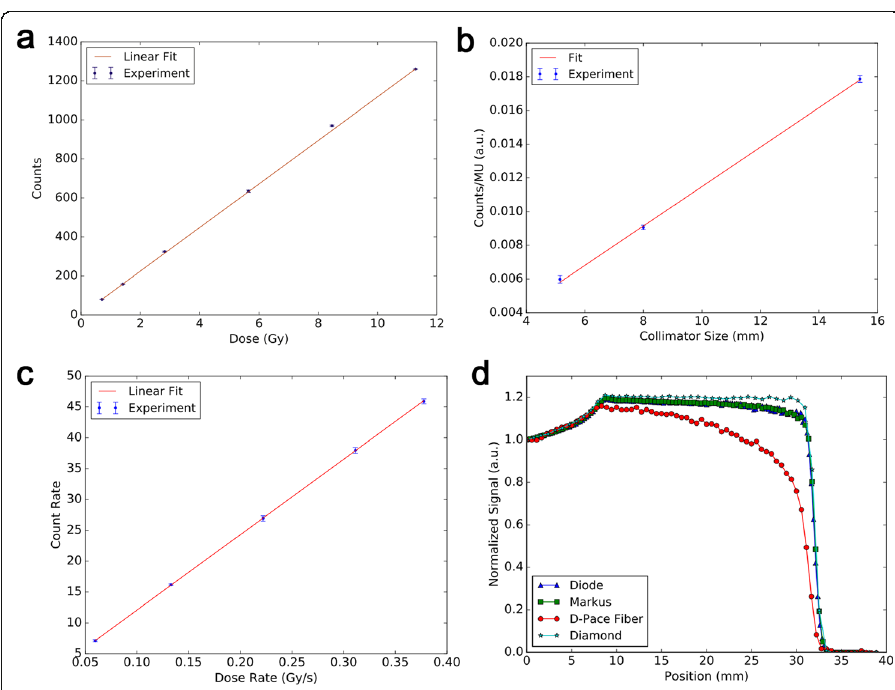
Fig. 10 The response of a Ce-doped silica based IOSFD to a 74MeV proton radiation source [74]. a Integrated counts as a function of set dose for the fiber. b Signal from fiber as a function of its irradiation length. c Count rate from the fiber as a function of dose rate. d Depth dose profiles for the Spread Out Bragg Peak using various